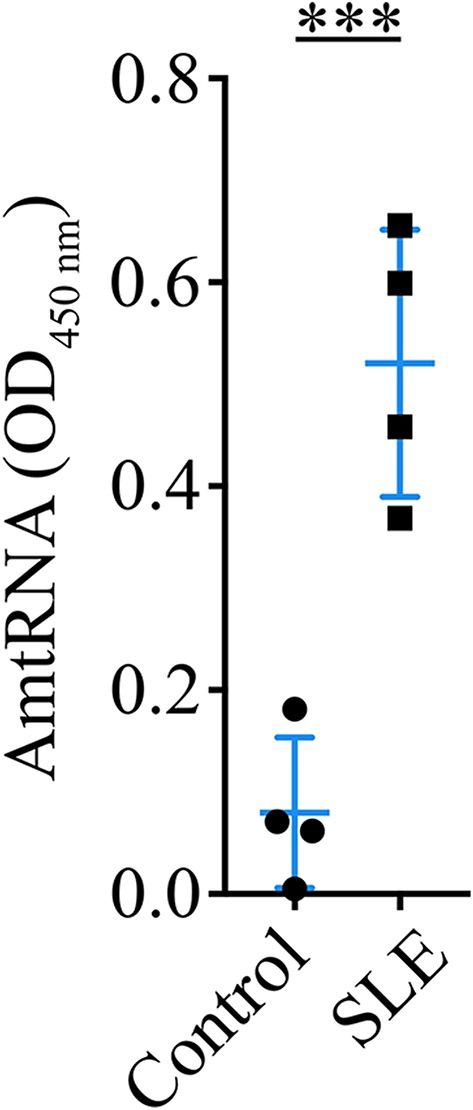
Circulating anti-mitochondrial RNA autoantibodies are detectable in sera from mice with induced SLE. Sera (1:50) from mice with induced SLE were incubated on ELISA plates coated with 200 ng murine mtRNA per well. Mice with induced SLE displayed a significant increase in serum antibodies against mtRNA in comparison to control mice. N = 4 mice per group. Data show the mean ± SD. Student's t-test. ***p < 0.001.